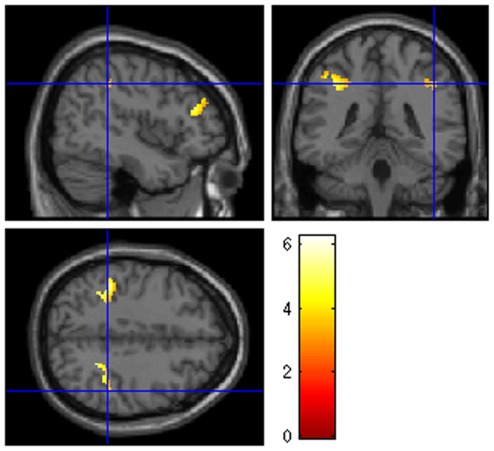
T-contrast maps showing significant biologically Salient>Neutral differences using regression map BOLD-behavior (see the main text) as inclusive mask (p<0.001, unc., cluster threshold = 30).For display purposes, statistical maps were overlaid on the Colin Holmes 27 (ch2) template of the international consortium for brain mapping (ICBM). Presented in neurological convention: R = R.